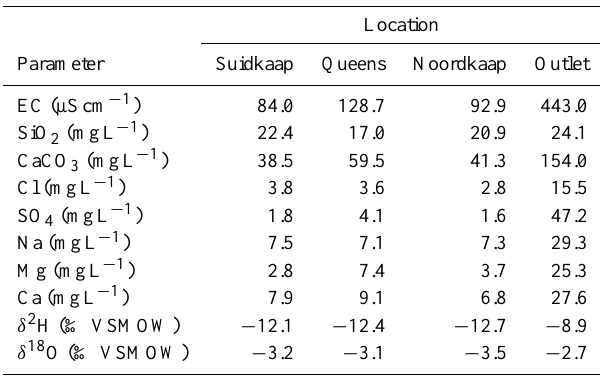
Table 3. List of mean values of hydrochemical parameters obtained during the 2013–2014 field